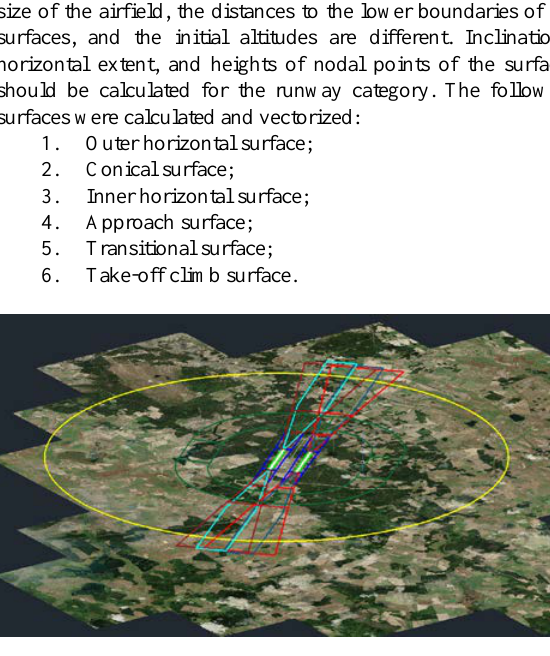
Figure 2. The obstacle limitation surfaces